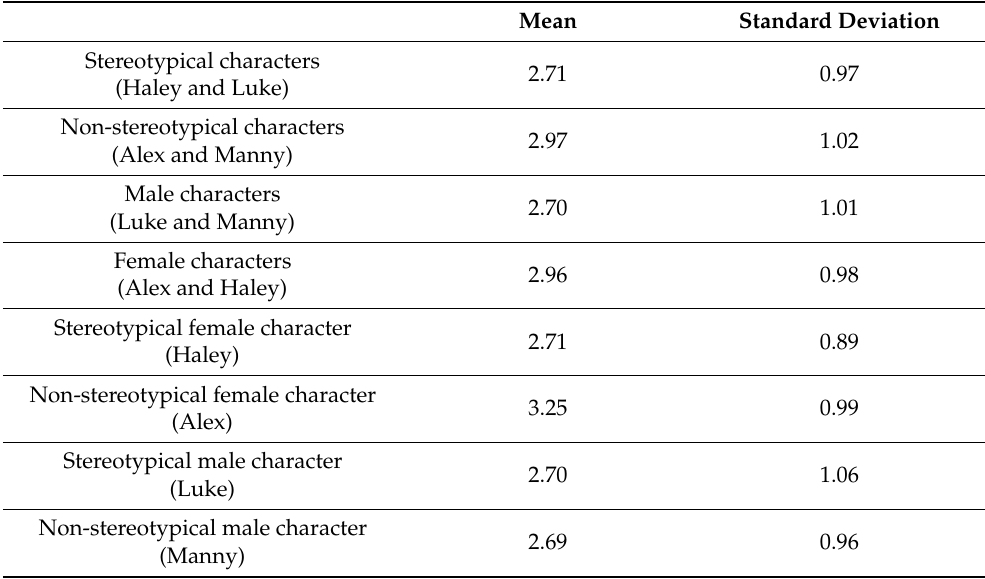
Table 1. Means and standard deviations of wishful identification with various character